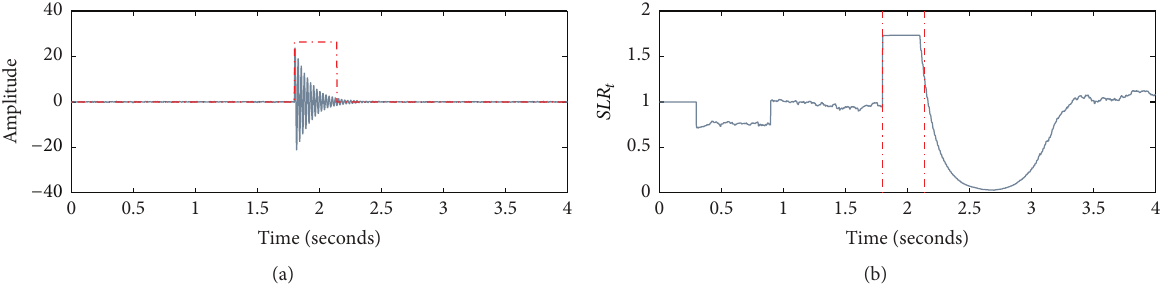
Figure 3: The application of the proposed method to a simulated signal described in Section 3. (a) Detection of the signal segment in the recorded dataset. (b) Sequence of the test statistics 𝑆𝐿𝑅 𝑡 , where the short and long time windows are equal to 0.3 s and 1.5s, respectively; the activation 𝜏 𝐴 and deactivation 𝜏 𝐷 thresholds correspond to 1.4 and 1.2 , respectively.